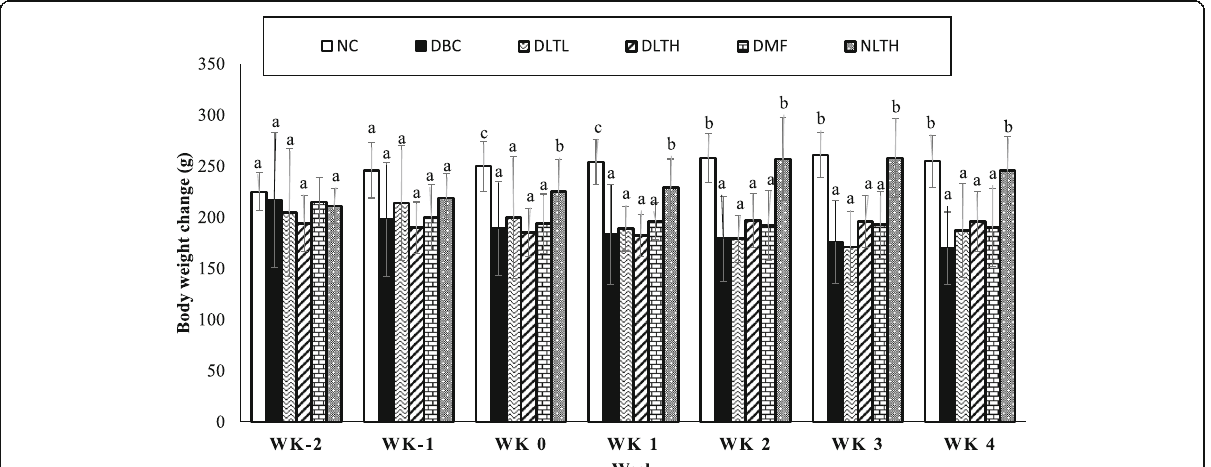
Fig. 2 Mean body weight changes in different animal groups during the experimental period. Data are presented as the mean ± SD of 7 animals. a,c Values with different letters over the bars for a given parameter are significantly different from each other group of animals (Tukey ’ s-HSD multiple range post hoc test, p < 0.05). NC- Normal control; DBC- Diabetic control; DLTL- Diabetic lemongrass tea low; DLTH- Diabetic lemongrass